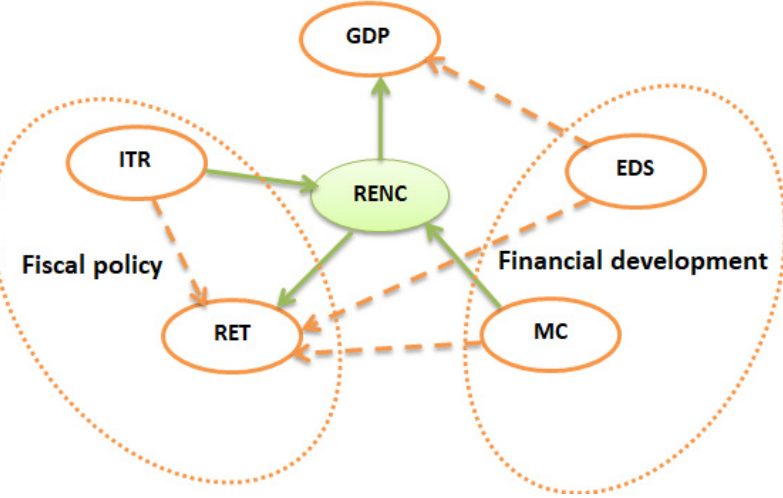
Figure 5. Summary of Granger causality relationships.